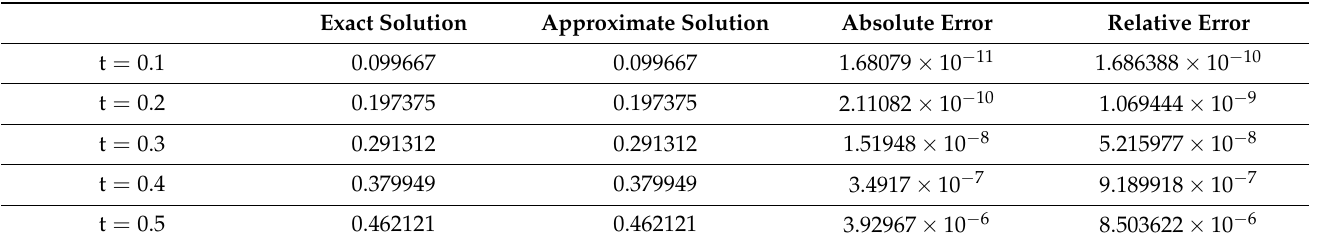
Table 2. The absolute and relative errors of the 11th approximate LRPS solution of problems (32) and (33) at β = 1 .